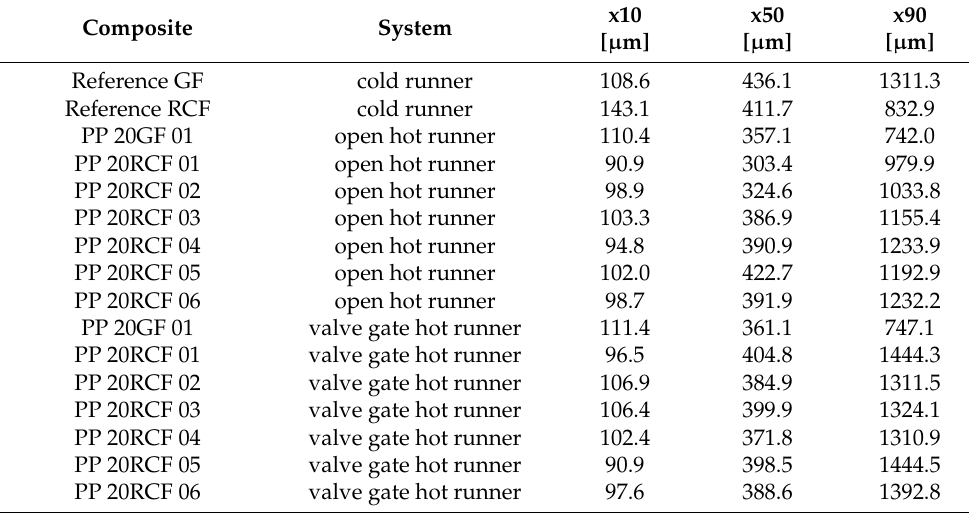
Table 6. Percentile values (10th, 50th and 90th) from the fiber length distributions of the characterized